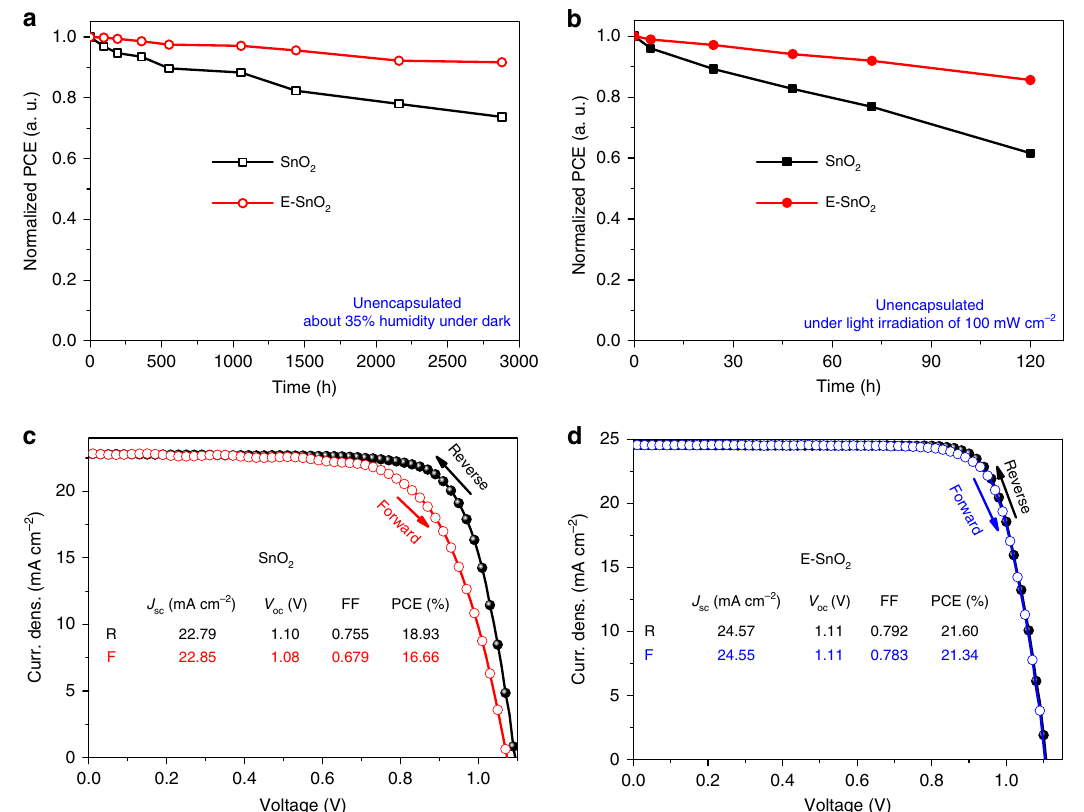
Fig. 6 Stability and hysteresis test for planar-type PSCs. Long-term stability measurements of devices without any encapsulation under a ambient condition and b illumination of 100 mW cm − 2 . The J – V curves of the device with c SnO 2 and d E-SnO 2 measured under both reverse- and forward-scan